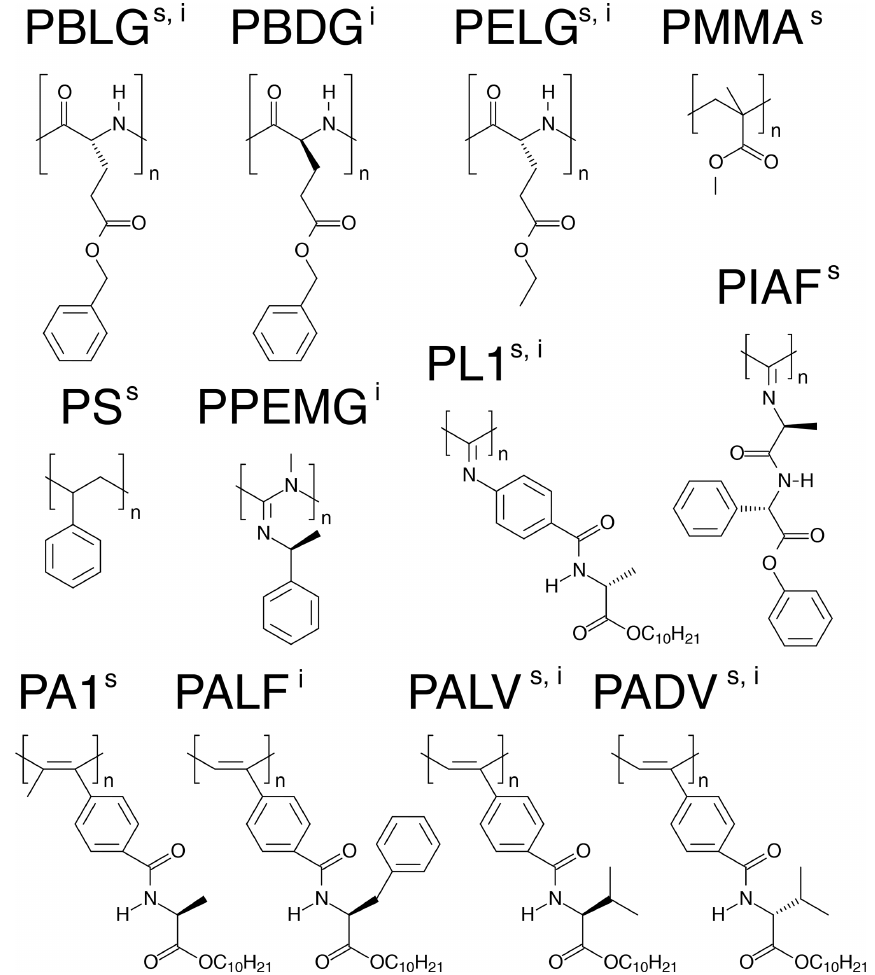
Figure 1. Representation of the basic units of the anisotropic media used for the alignment of strychnine (s) and ( − )-IPC